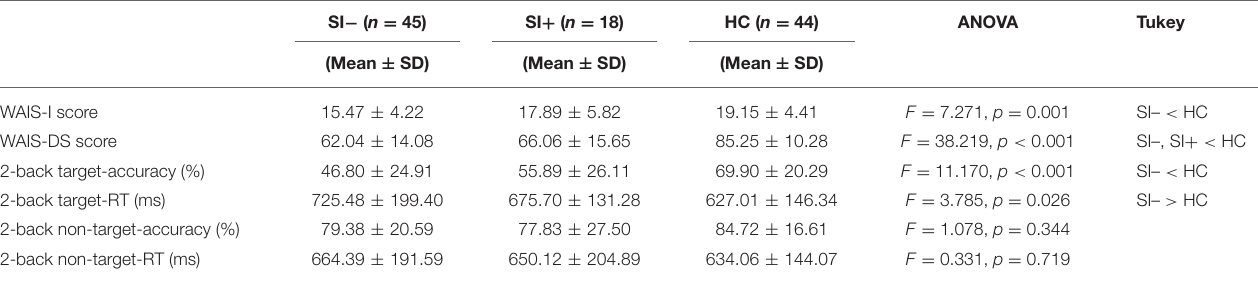
TABLE 2 | The between-group comparisons on cognitive performances among the patients without suicidal ideation (SI–), the patients with suicidal ideation (SI + ) and healthy controls (HC) using one-way analysis of variance (ANOVA) followed by Tukey HSD post-hoc tests. SI − ( n =